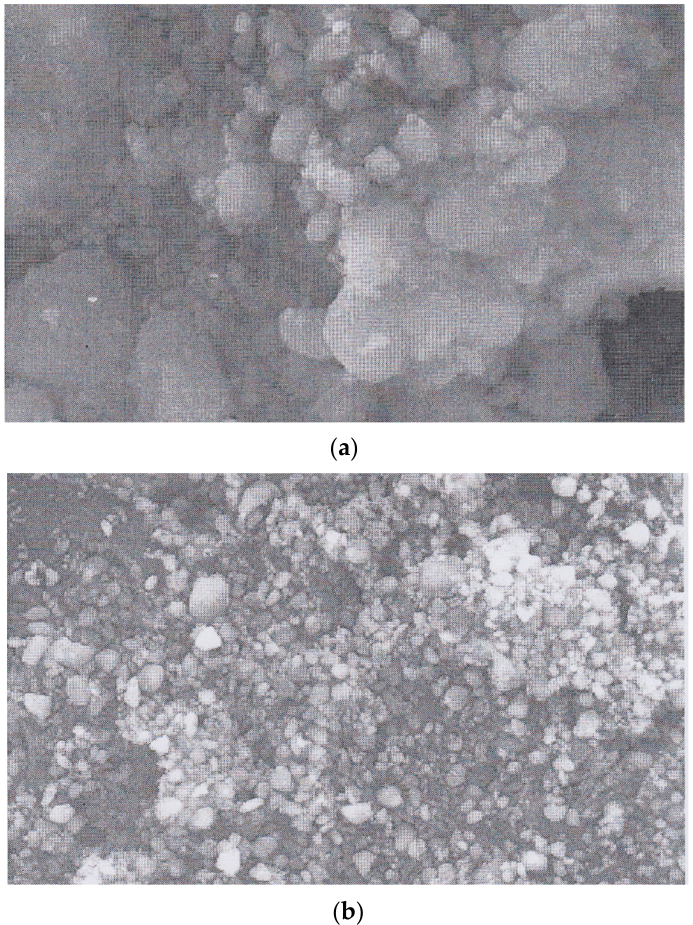
Figure 3. ( a ) Control sample of unmodified fumed silica NPs ( b ) Plasma treated